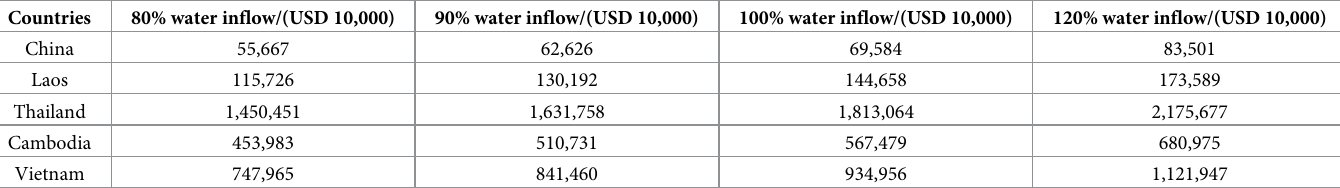
Table 4. Benefits of grain production under the allocation of water resources in five countries. Countries 80% water inflow/(USD 10,000)